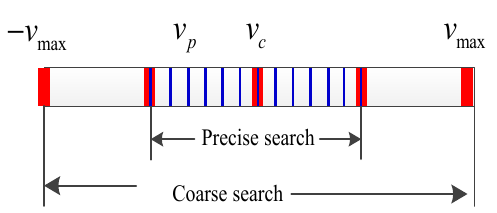
Figure 1. Flow chart.